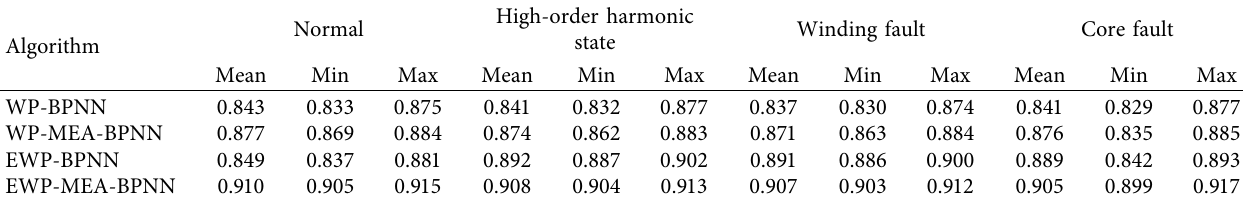
Table 6: Diagnostic accuracy of the models for different operating states after 30 independent runs. High-order Normal Algorithm